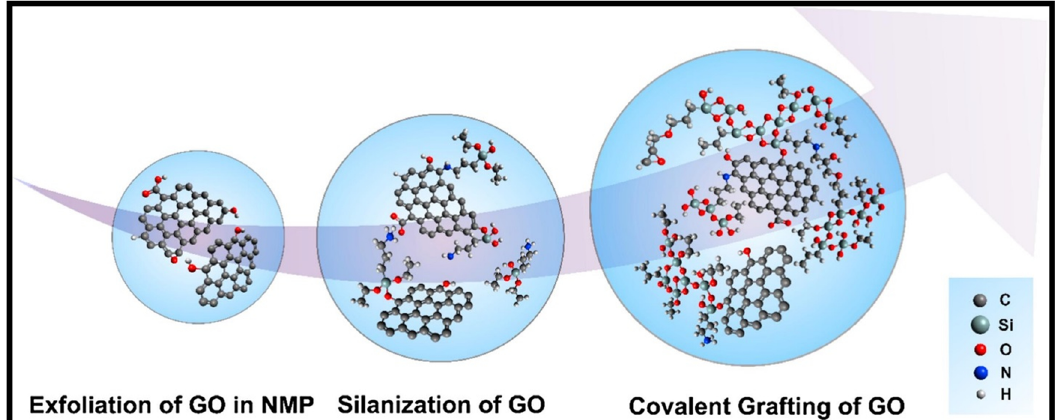
Figure 24: Schematic diagrams for the preparation of GO functionalized with APTES incorporated in an organosiloxane matrix ( f - GO/sol ) [ 173 ]